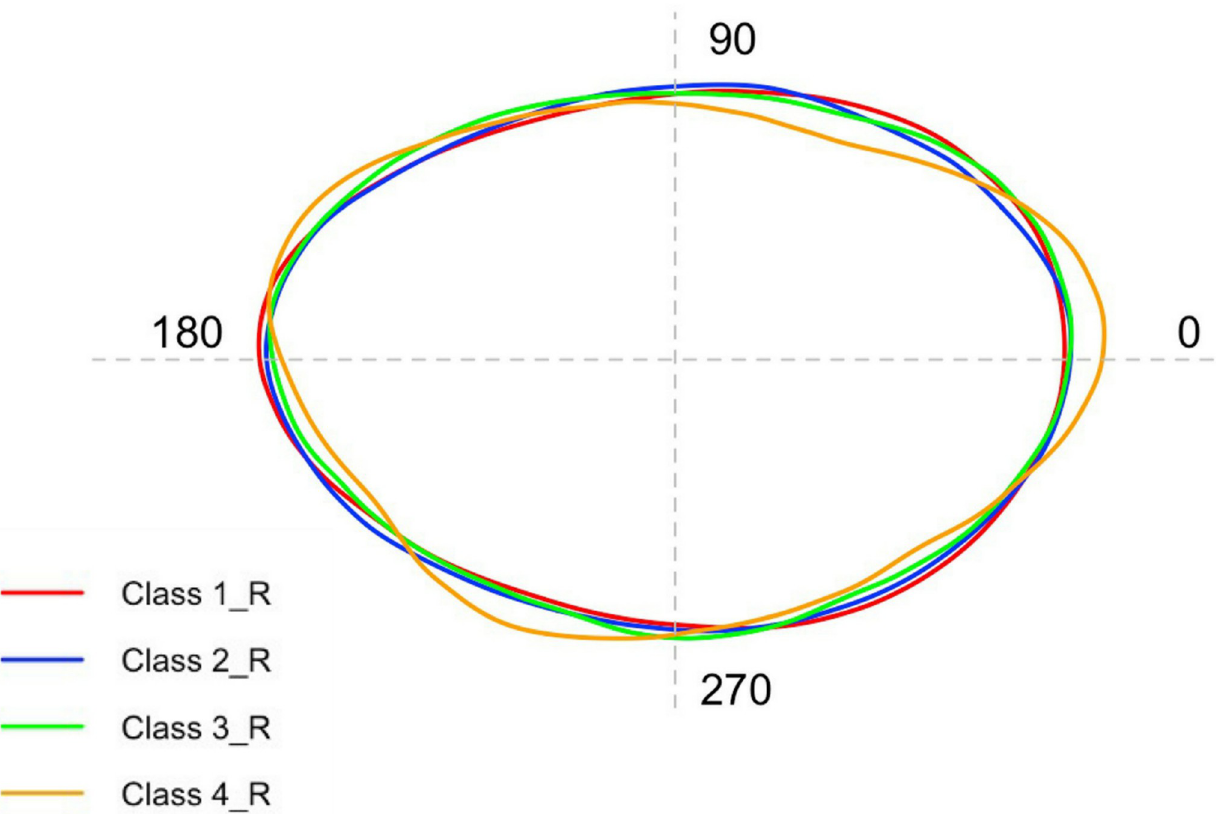
Fig 7. Mean shape of right lapilli contours belonging to the four investigated size